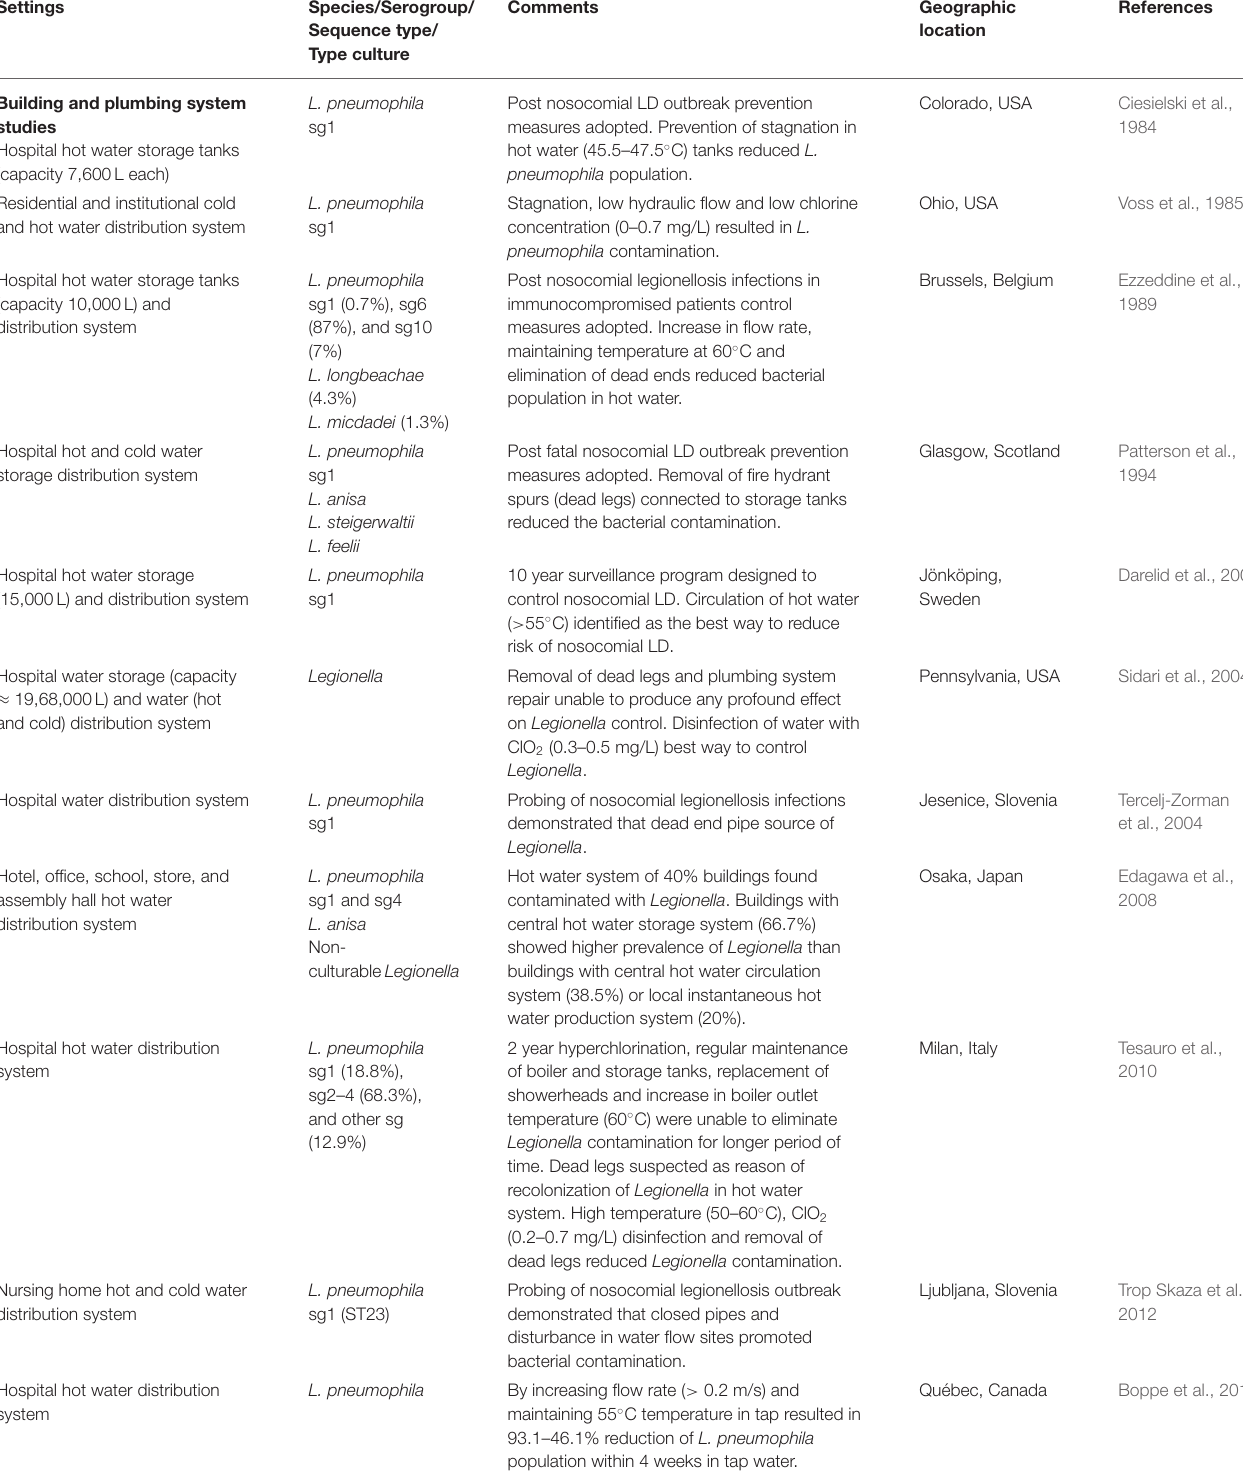
TABLE 1 | Relationship between water stagnation and Legionella